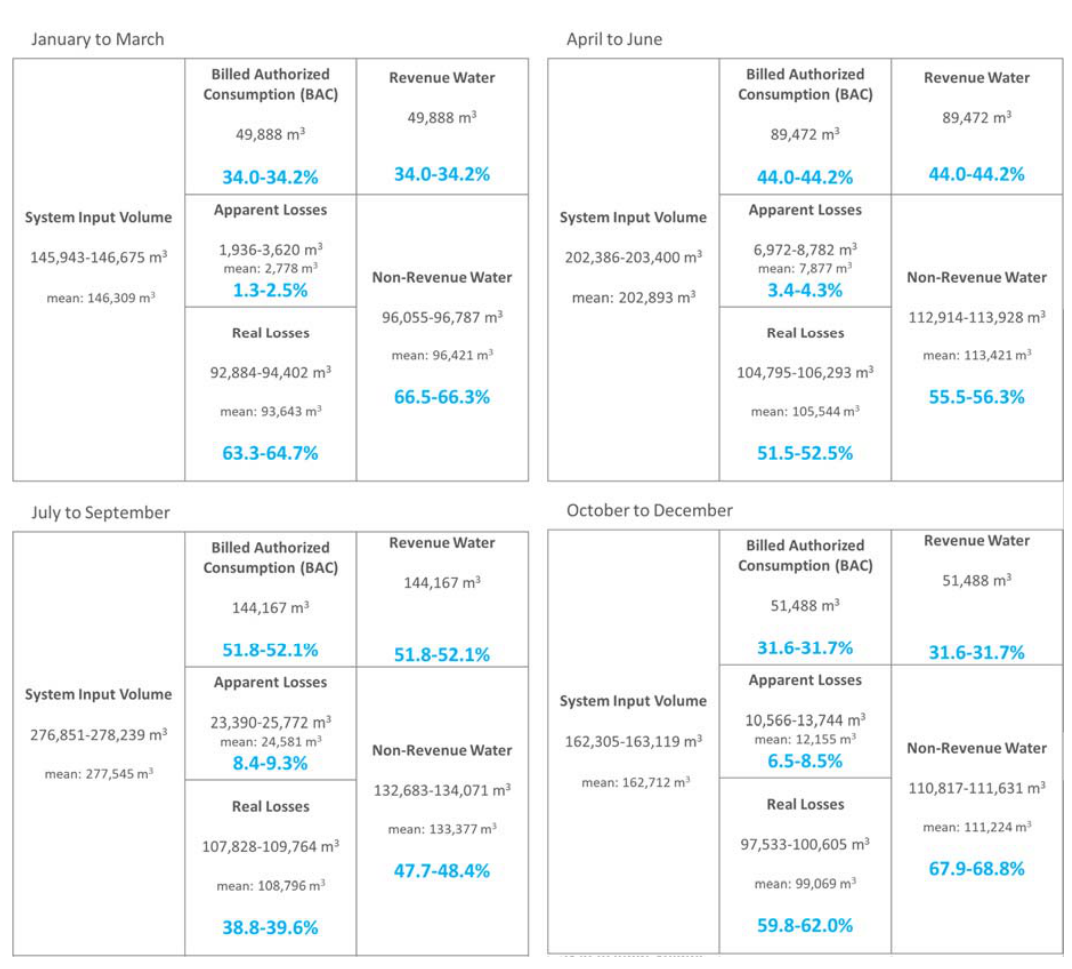
Figure 15. Seasonal high-level component analysis of SIV into billed authorized consumption (BAC), apparent losses, real losses, revenue water and nonrevenue water (all components are also presented as percentages of